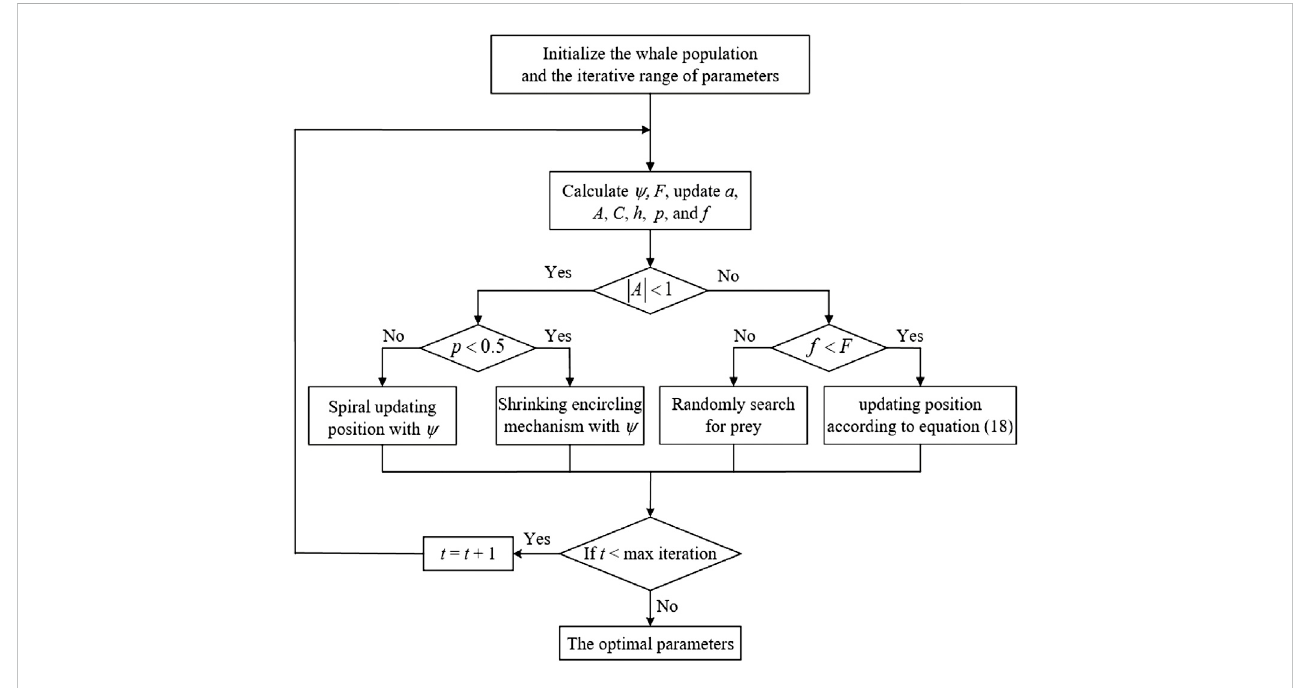
FIGURE 1 Flowchart of the proposed SAWOA-MPE